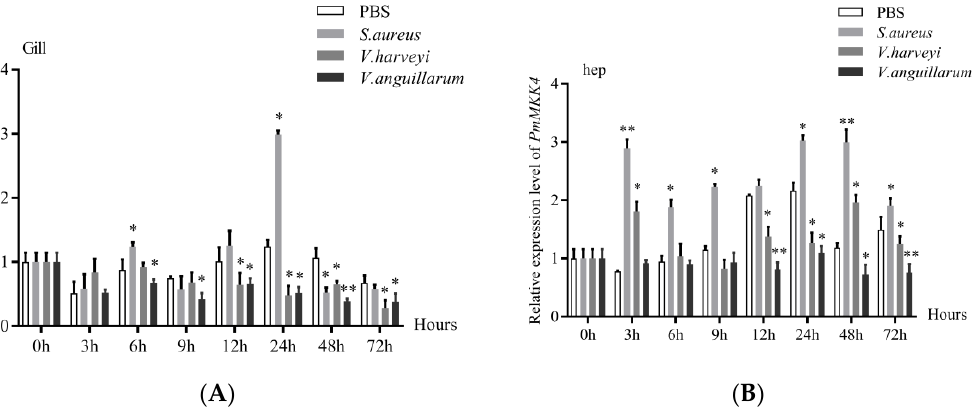
Figure 5. Expression of PmMKK4 in P. monodon after bacterial stimulation. Expression of PmMKK4 in gill ( A ) and hepatopancreas ( B ) after stimulation by S. aureus , V. harvey and V. anguillus . Vertical bars represent the mean ± S.E (n = 3). Significant differences are indicated by * ( p < 0.05) and ** ( p < 0.01).